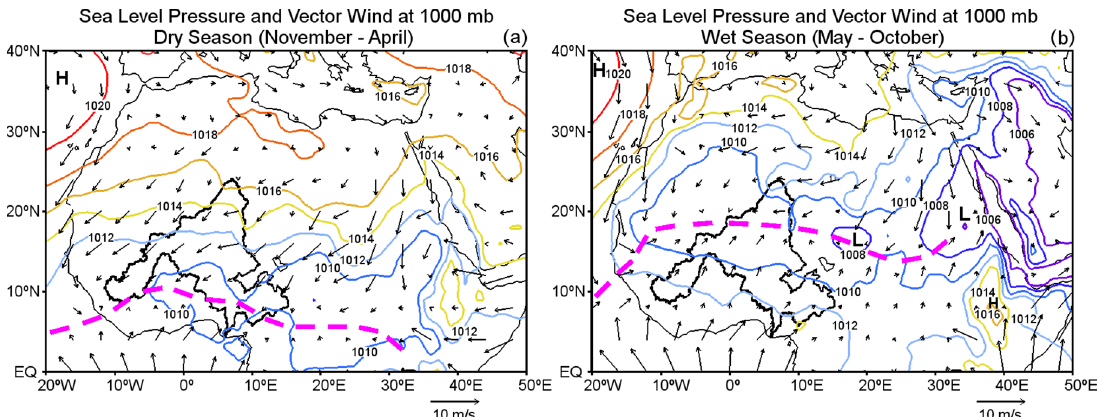
Figure 2. Climatological schematic diagram of mean sea level pressure (colour contours, in mb) and winds (arrows, in m/s) at 1000 mb from ERA-Interim, for the period 1980–2014 during NDJFMA ( a ) and MJJASO ( b ). The discontinued magenta line represents the confluence of winds and the black contour in West Africa indicates the boundary of the NRB.